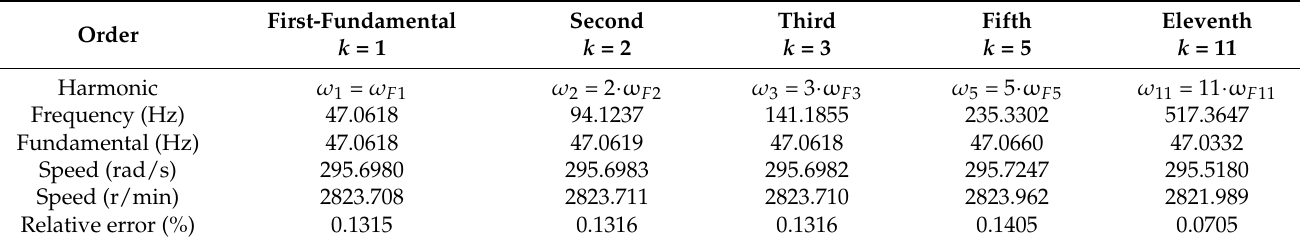
Table 1. Five frequency peaks of the spectrum corresponding to the motor noise signal for no-load test at 2820 r/min (295.3097